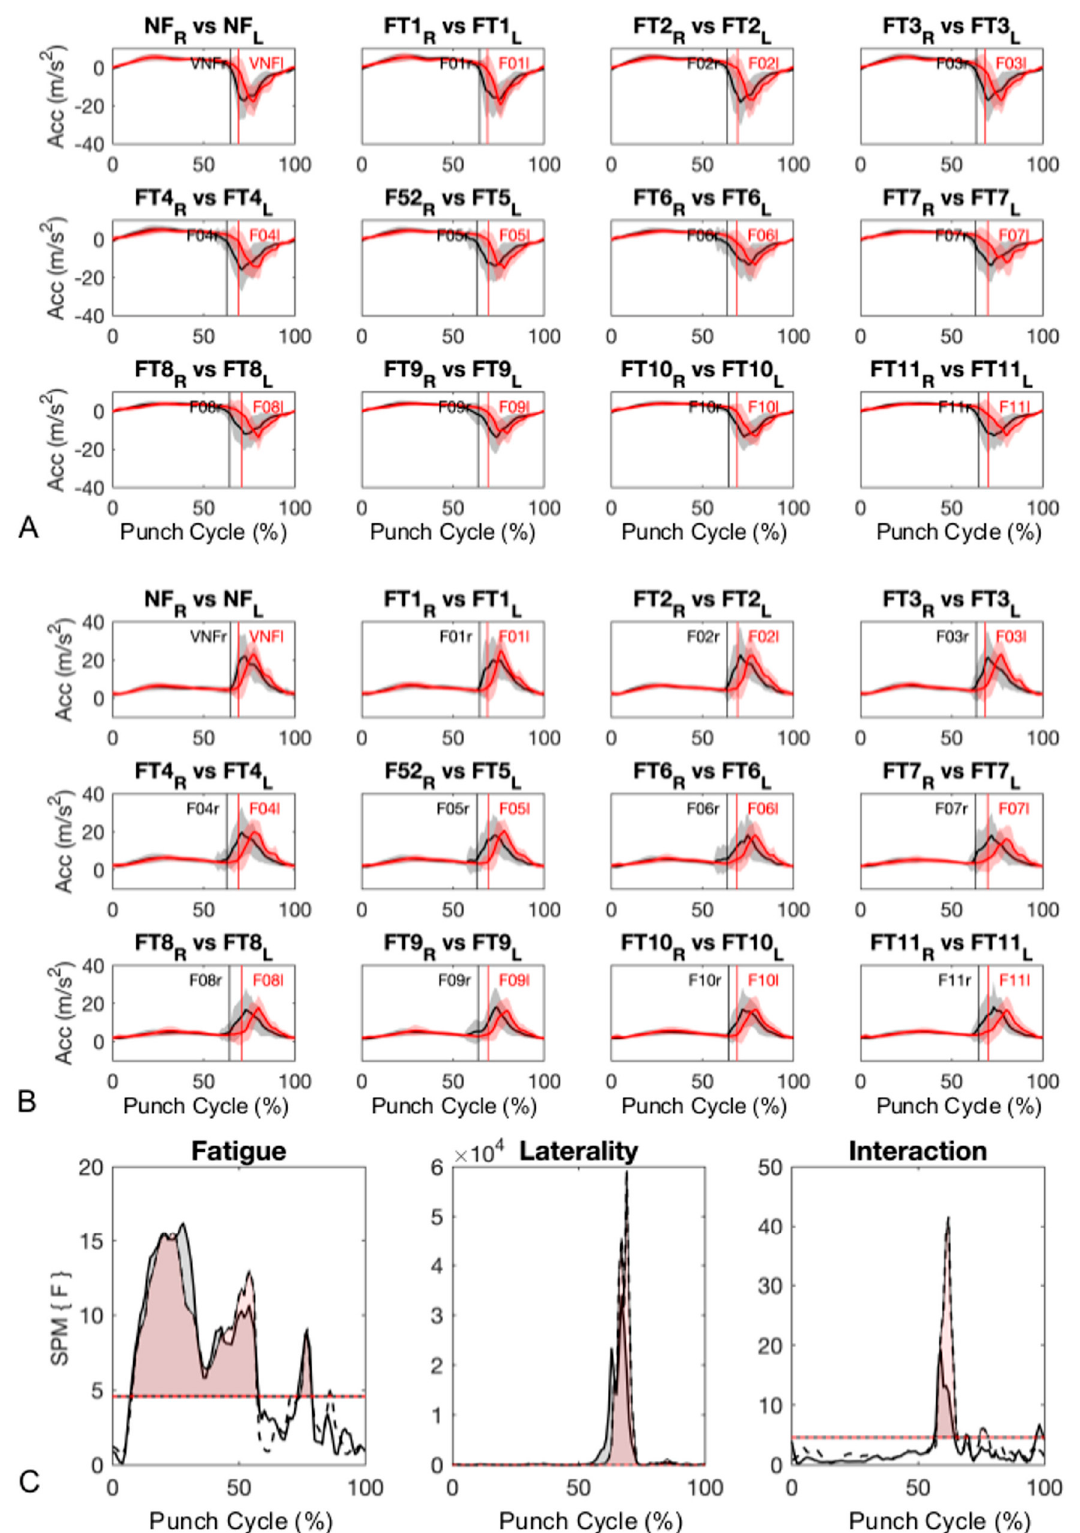
Figure 3. ( A ) Anterior–posterior (AP) and ( B ) resultant acceleration for right (black lines) and left (red lines) hand punches. Vertical lines show average impact point for both fatigued (FT) and non-fatigued (NF) trials, while 0% and 100% correspond to the beginning of the pre-impact and end of the impact phases, respectively. ( C ) Results from the within-subject one ANOVA using a statistical parametric mapping approach for AP component (solid black line) and resultant (dashed black line) accelerations. Periods showing a statistically significant difference are highlighted by grey (anterior–posterior) and red (resultant) areas above critical F statistic.